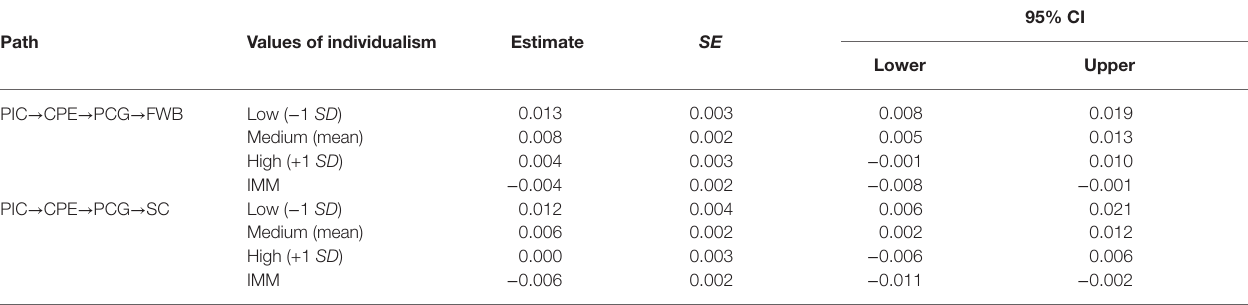
TABLE 8 | Serial moderated mediation results in the pooled sample.